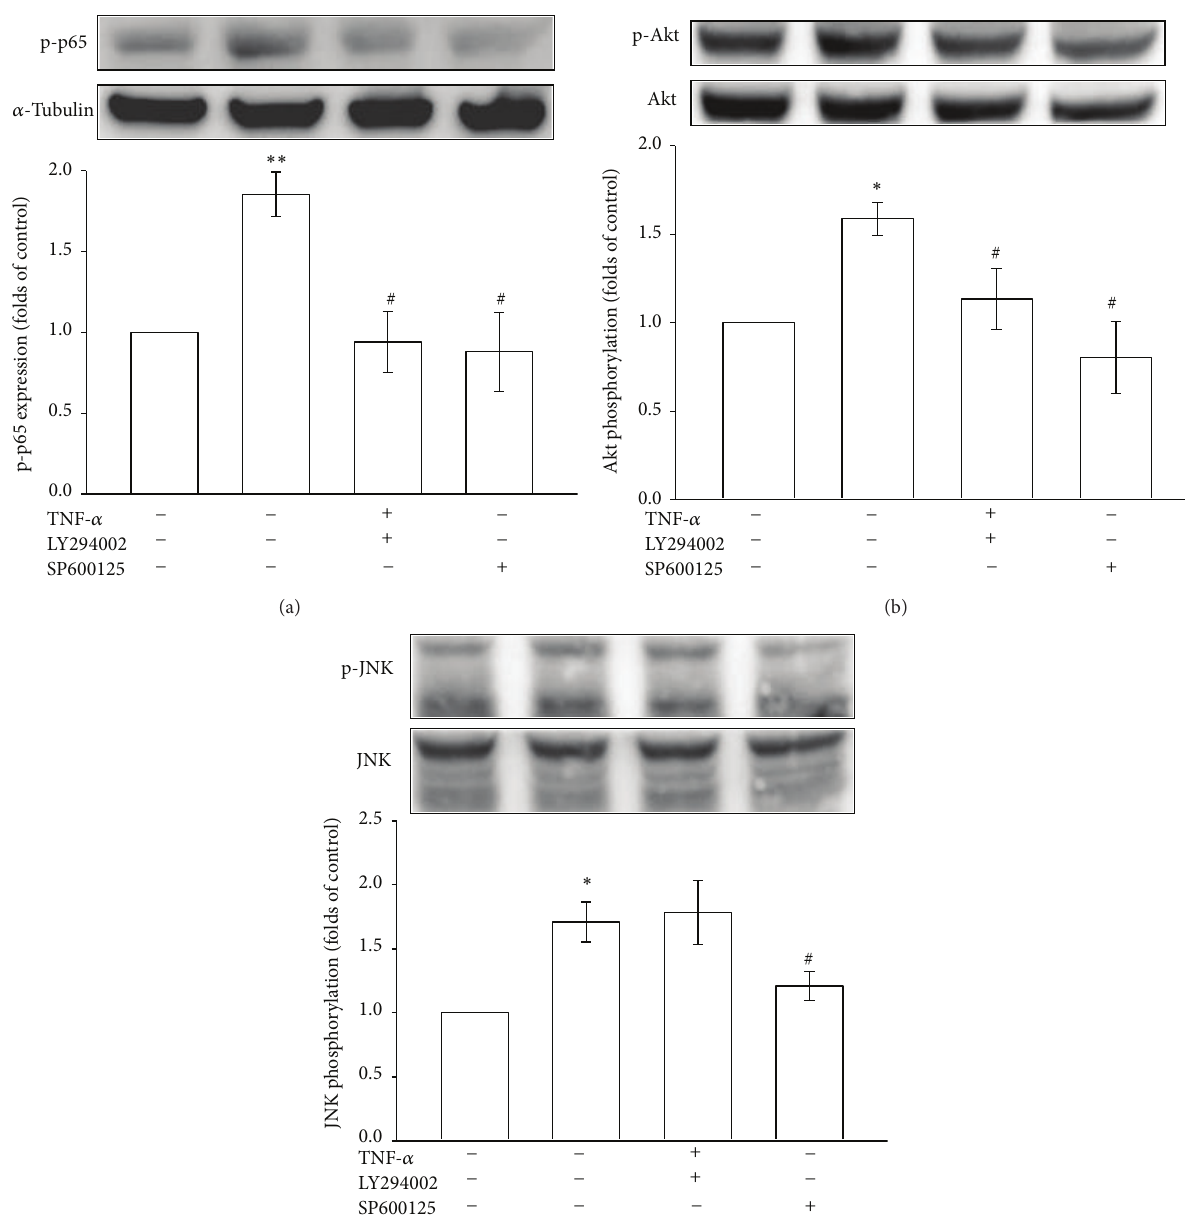
Figure 5: Regulatory effects of various signal inhibitors on p65 activation and Akt and JNK phosphorylation in TNF- 𝛼 -stimulated VSMCs. The VSMCs were treated with PBS (resting group) or pretreated with LY294002 (10 𝜇 M), SP600125 (10 𝜇 M), or an equal volume of DMSO (solvent control) for 20 min, and TNF- 𝛼 (10ng/mL) was subsequently added for 10 min ((b) and (c)) or 30min (a). (a) p65 phosphorylation, (b) Akt phosphorylation, and (c) JNK phosphorylation were evaluated as described in Section 2. ∗ 𝑃 < 0.05 and ∗∗ 𝑃 < 0.01 compared with the resting group; # 𝑃 < 0.05 compared with the TNF- 𝛼 group. The data are presented as the mean ± SEM ( 𝑛 = 3